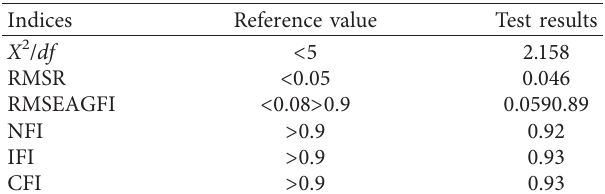
Table 6: Goodness of fit